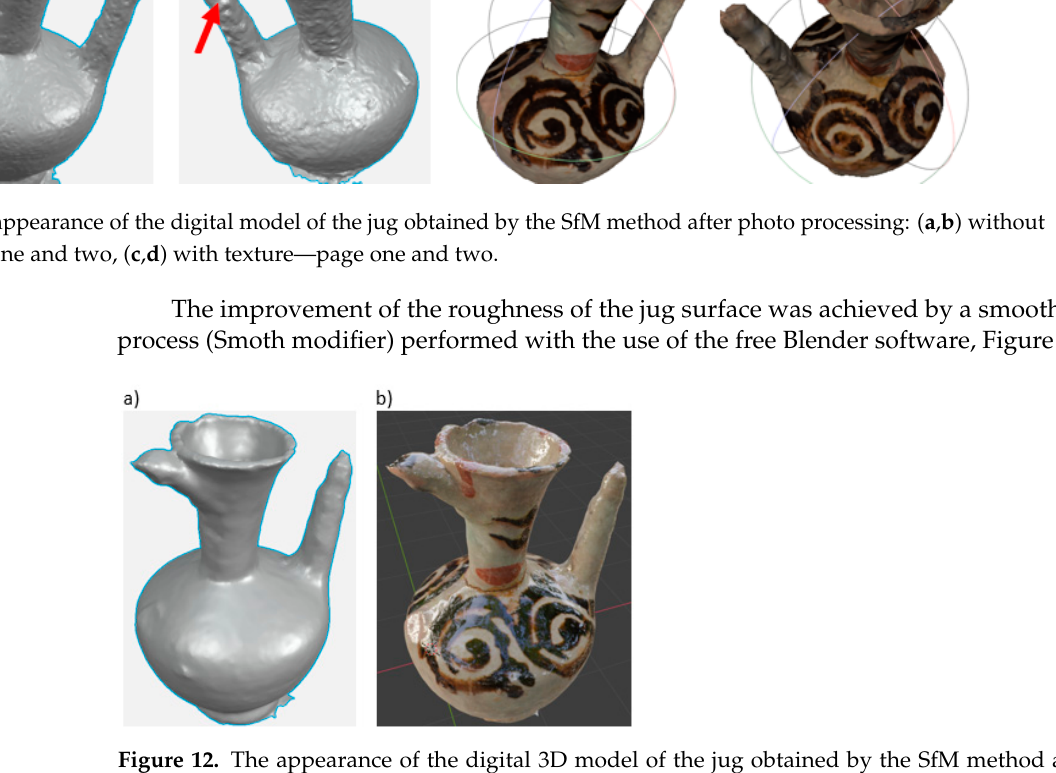
texture—page one and two, ( c , d ) with texture—page one and two.